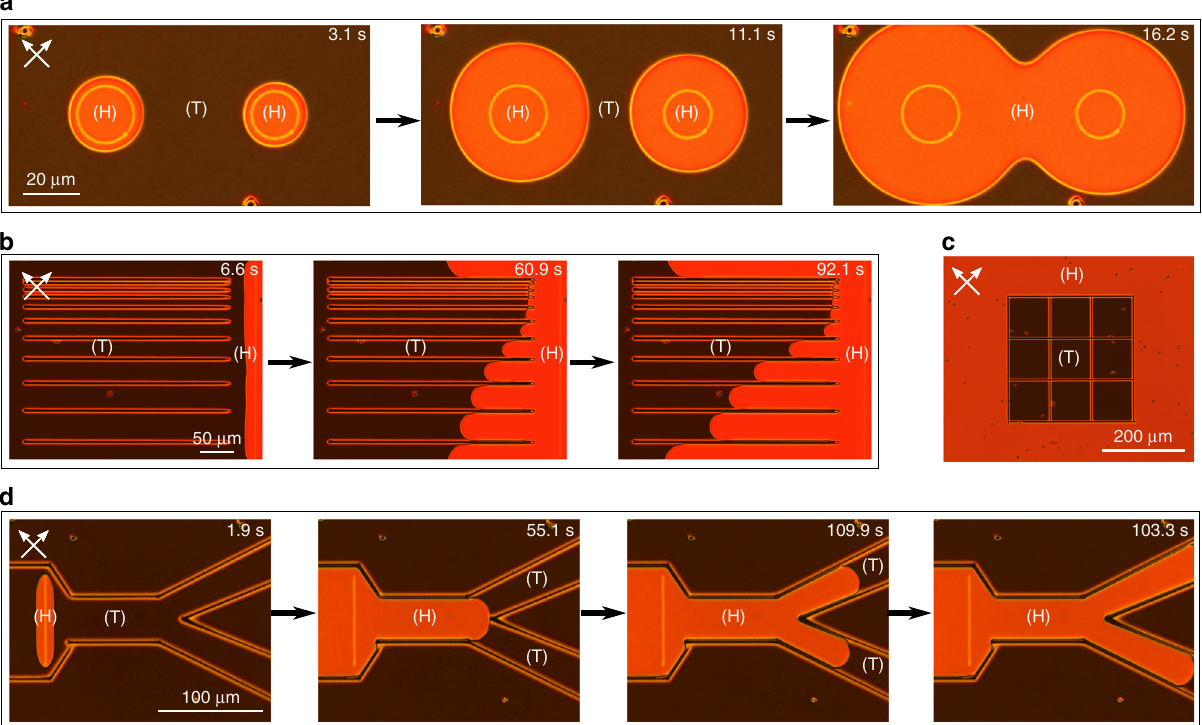
Fig. 4 Complex polymer structures for tunable disclination line control. a Polarising optical microscopy (POM) images of circular disclination lines growing as the device relaxes to the ground state. b POM images of defect-con fi nement channels. Varying the spacing between adjacent laser-written V- state walls affects the speed of a defect passing through the channels. c POM image of a 100 µ m pitch V-state polymer lattice in the absence of an applied voltage. The V-state polymer walls comprising the square lattice stabilise the twisted state, preventing the relaxation to the H-state within the square wells, even at zero voltage. d POM images of a micro fl uidics-inspired bifurcated defect channel. The walls de fi ning the channel were laser-written in the V-state while, inside the channel, a wall was written in the H-state. When the voltage is switched off at t = 0, the H-state nucleates from this wall and a defect travels down the